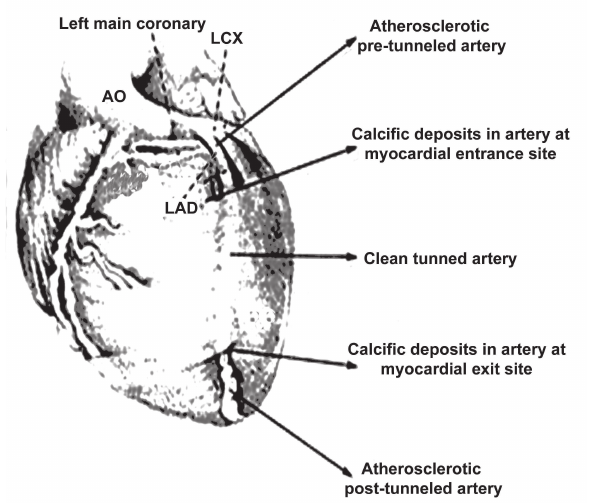
Fig. 1 - Major anatomopathological aspects (adapted Bourassa and colleagues